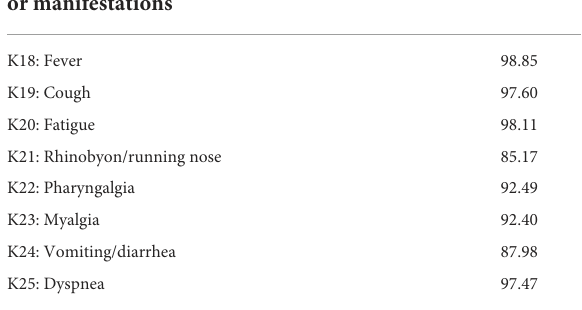
TABLE 4 Preventive measures for SARS-CoV-2